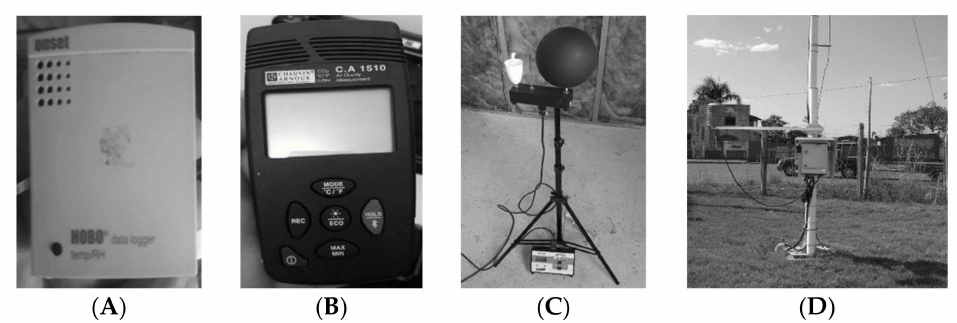
Figure 4. Equipment used: ( A ) Temperature sensor; ( B ) CO 2 concentration meter; ( C ) Black globe thermometer; ( D ) INMET Meteorological